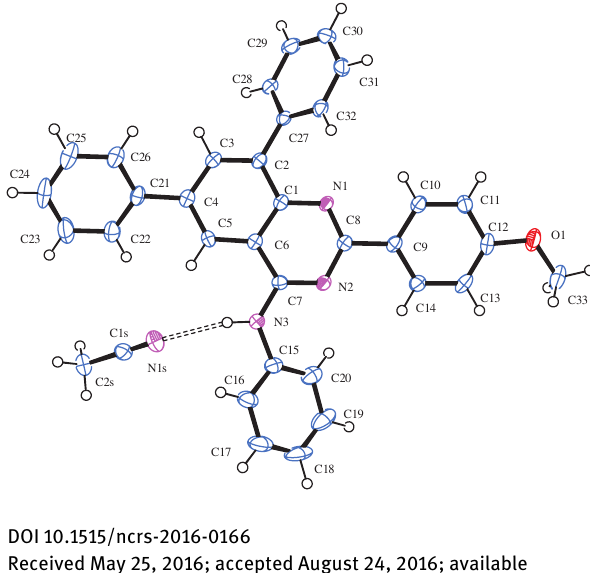
Table 1: Data collection and handling.